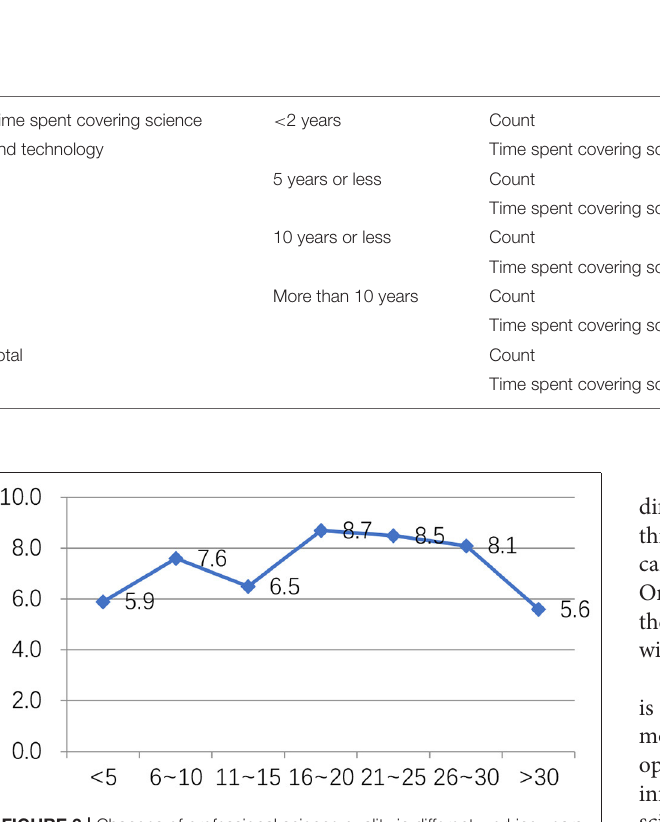
FIGURE 3 | Changes of professional science quality in different working